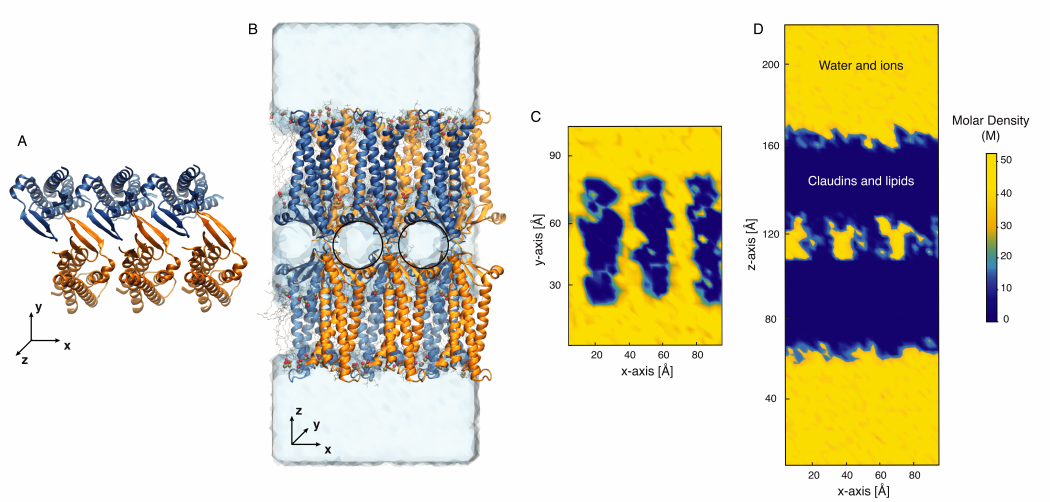
Figure 2. A refined model of claudin-15 paracellular channels [25]. Claudin-15 monomers assemble into double-row strands and form paracellular channels. ( A ) Top view of six claudin-15 monomers assembling into a double-row strand. ( B ) Snapshot of the simulation system showing claudin-15 monomers assembled between adjacent lipid bilayers. The pore regions are marked with circles. The water density across the simulation system and averaged over ∼ 250 ns of MD simulations, is shown: ( C ) parallel to the two membranes crossing the pores in the middle and ( D ) normal to the two membranes and crossing the pores in the middle. Figure is taken from [25] with slight